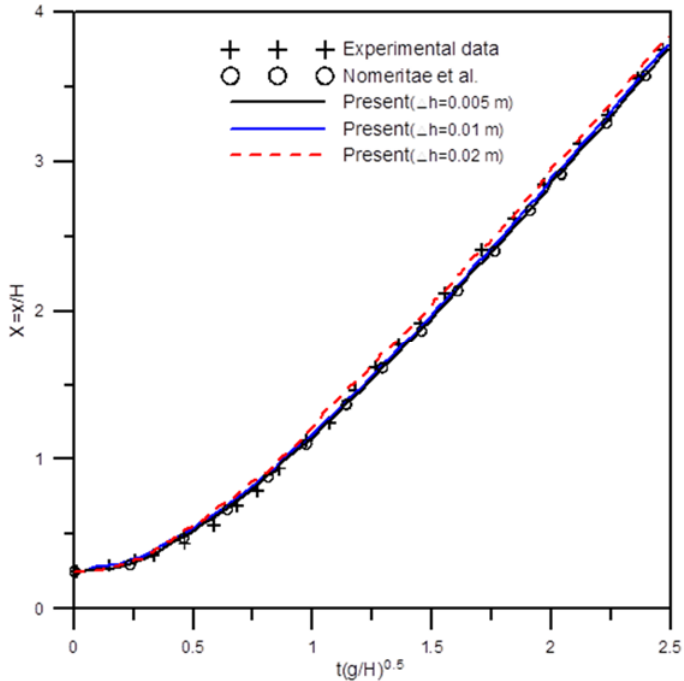
Figure 9. Comparisons between measured [52], EISPH [53] model, and present simulated leading-edge position at different times, with initial water volume of 0.057 m in length and height.